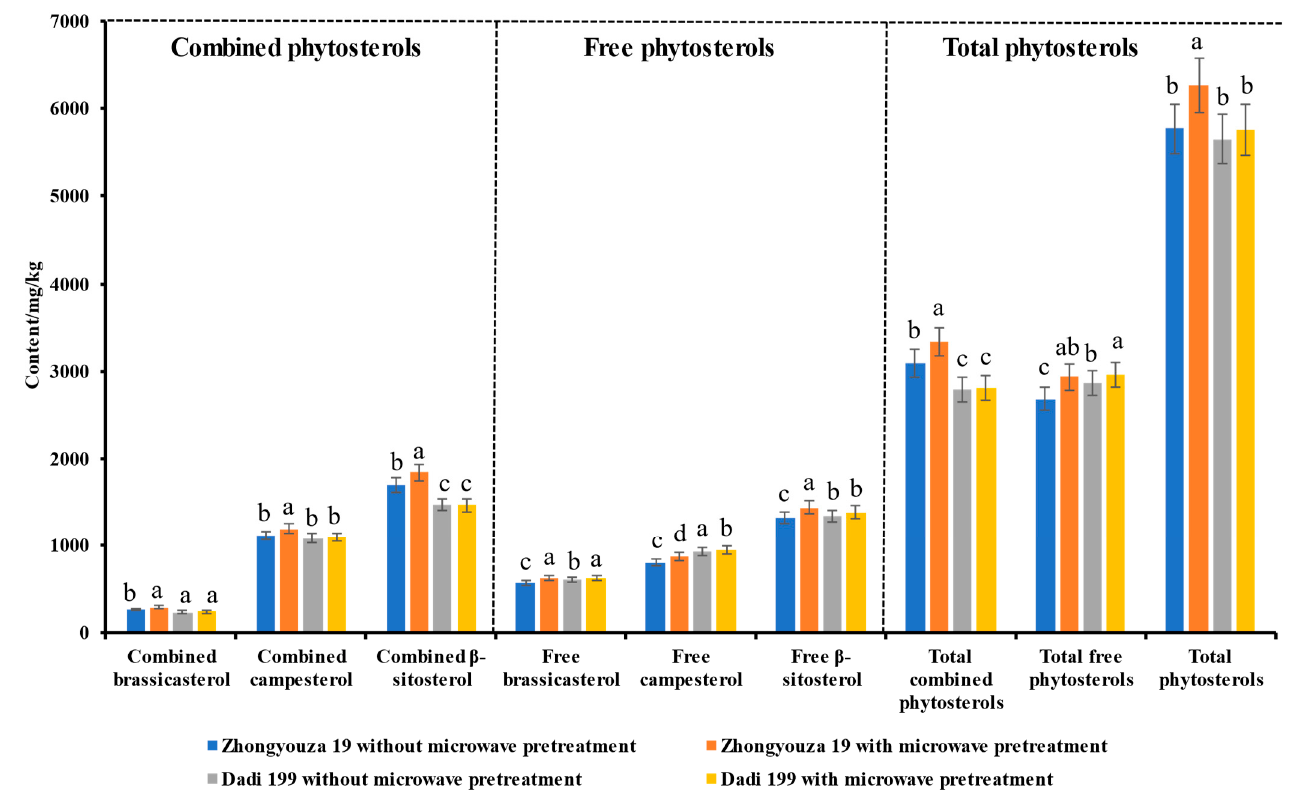
Figure 6. Effects of microwave pretreatment on the composition and content of phytosterols in rapeseed oil. Values are the means ± standard deviations; n = 3 parallel determinations. a–c Mean values (a > b > c, corresponding to the same parameter) not followed by a common letter differ significantly ( p < 0.05).